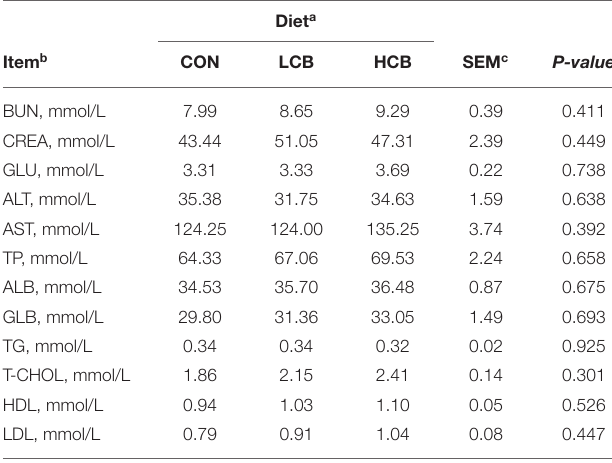
TABLE 5 | Effects of different doses of C. butyricum on rumen fermentation of fattening goats. Item CON